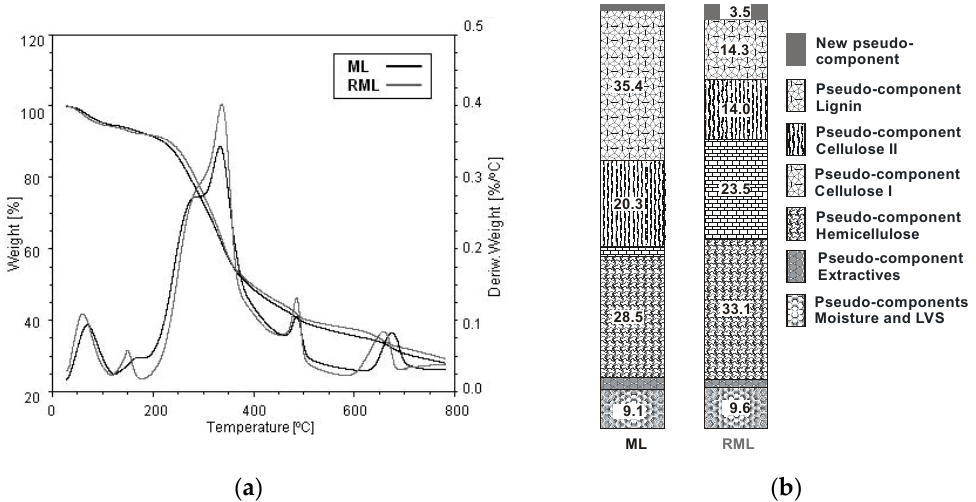
Figure 7. TGA and DTG curves ( a ) along with the results of deconvolution of the DTG curve ( b ) of ML and RML samples.